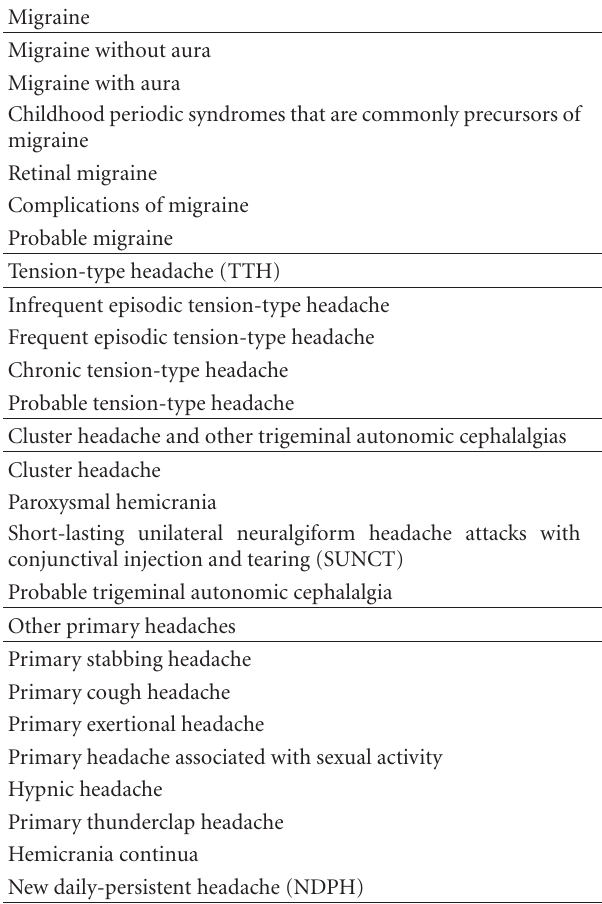
Table 1: International Classification of Headache Disorders. Migraine Migraine without aura Migraine with aura Childhood periodic syndromes that are commonly precursors of